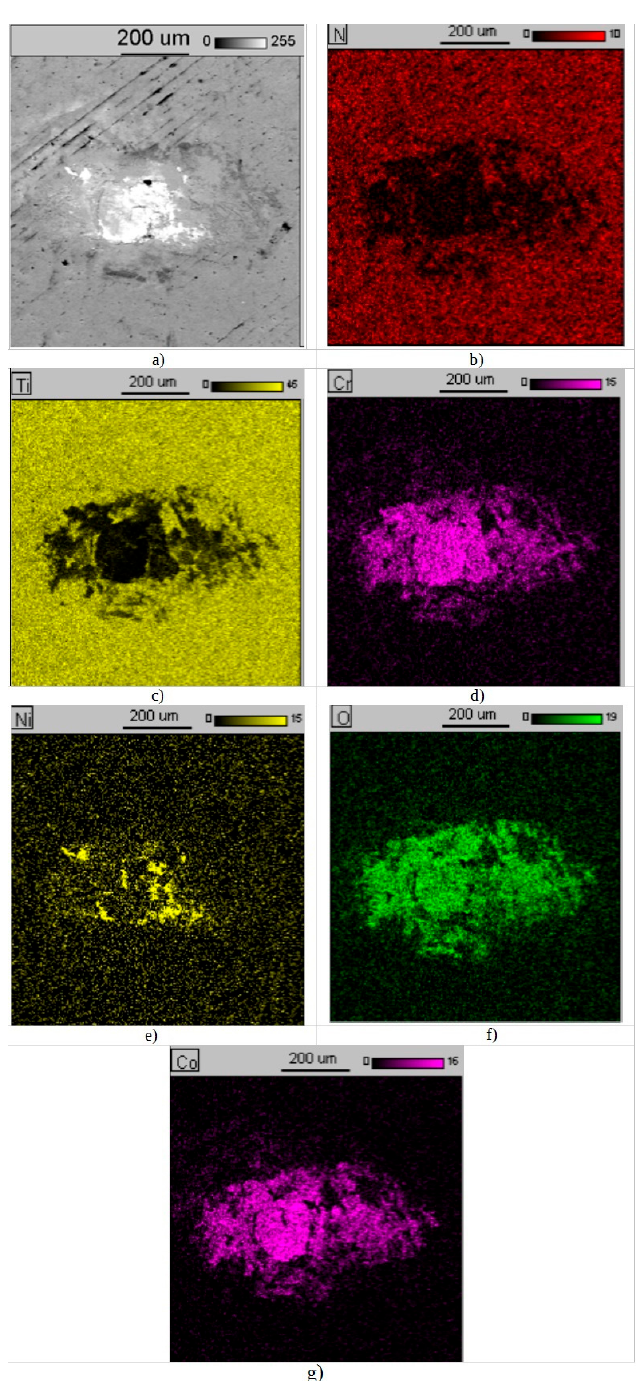
Figure 9. Microscopic image ( a ) and element distributions ( b – g ) in the friction area of sample S5. Parameters-load 15 N, time 120 min.